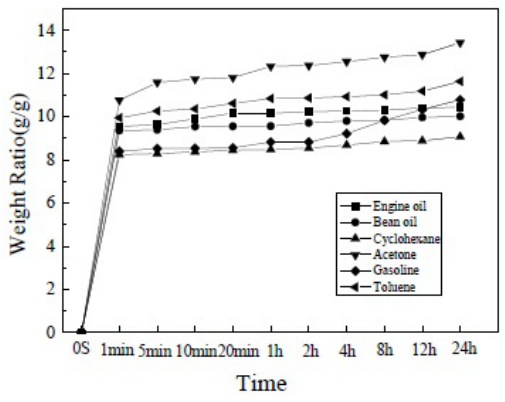
Figure 8: The changes of the oil adsorption rate with the time for different oily substances